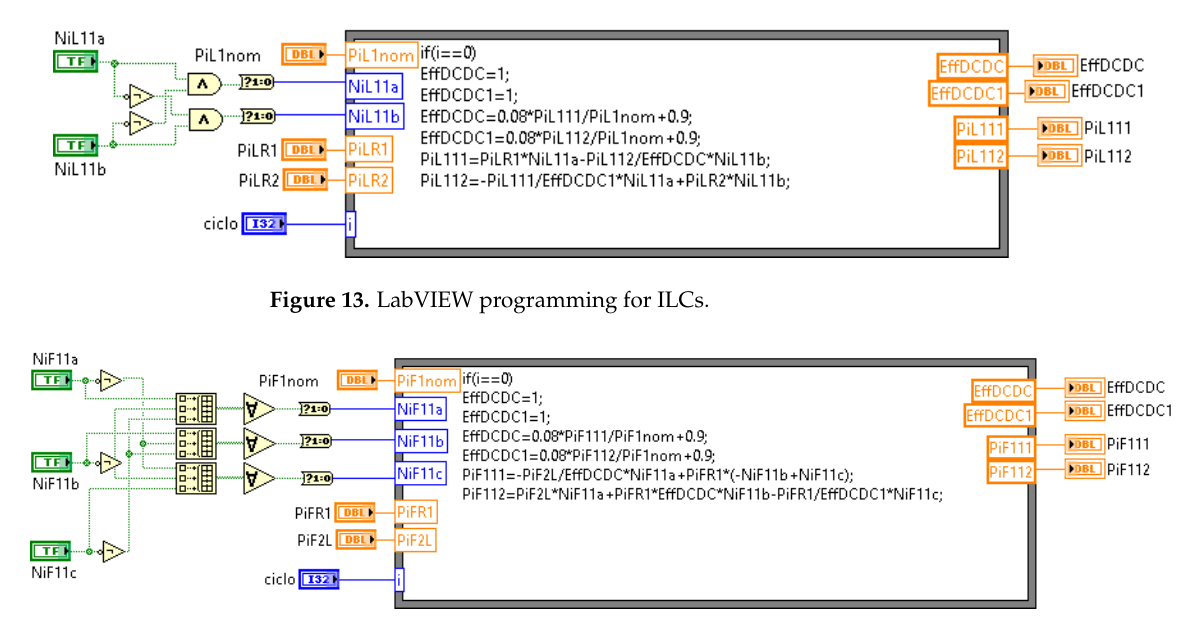
Figure 12. LabVIEW programming for ESUs.